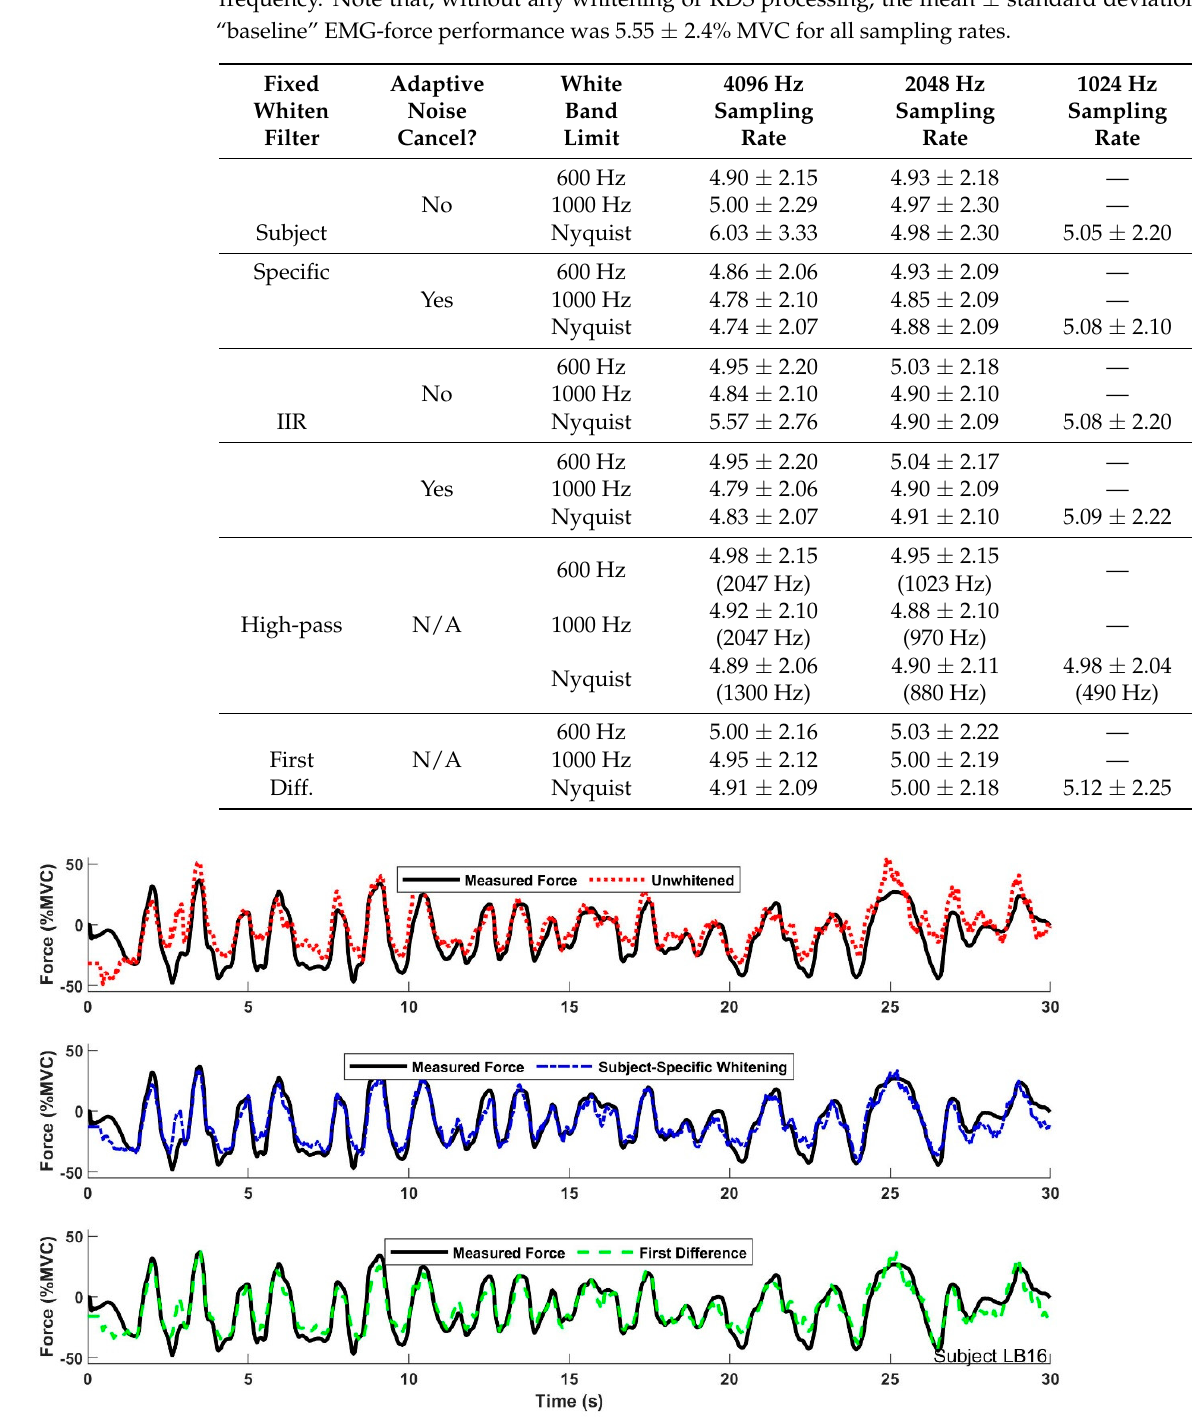
Table 1. Mean ± std. deviation of EMG-force errors (% MVC) for different whitening filter methods ( N = 64), with RDS processing. Results shown for conditions: with vs. without use of adaptive noise canceling, different whitening bandwidth limits (“Nyquist” denotes no limiting used), and different sampling rates. For the high-pass whitening method, each result lists the optimal filter cut-off frequency. Note that, without any whitening or RDS processing, the mean ± standard deviation